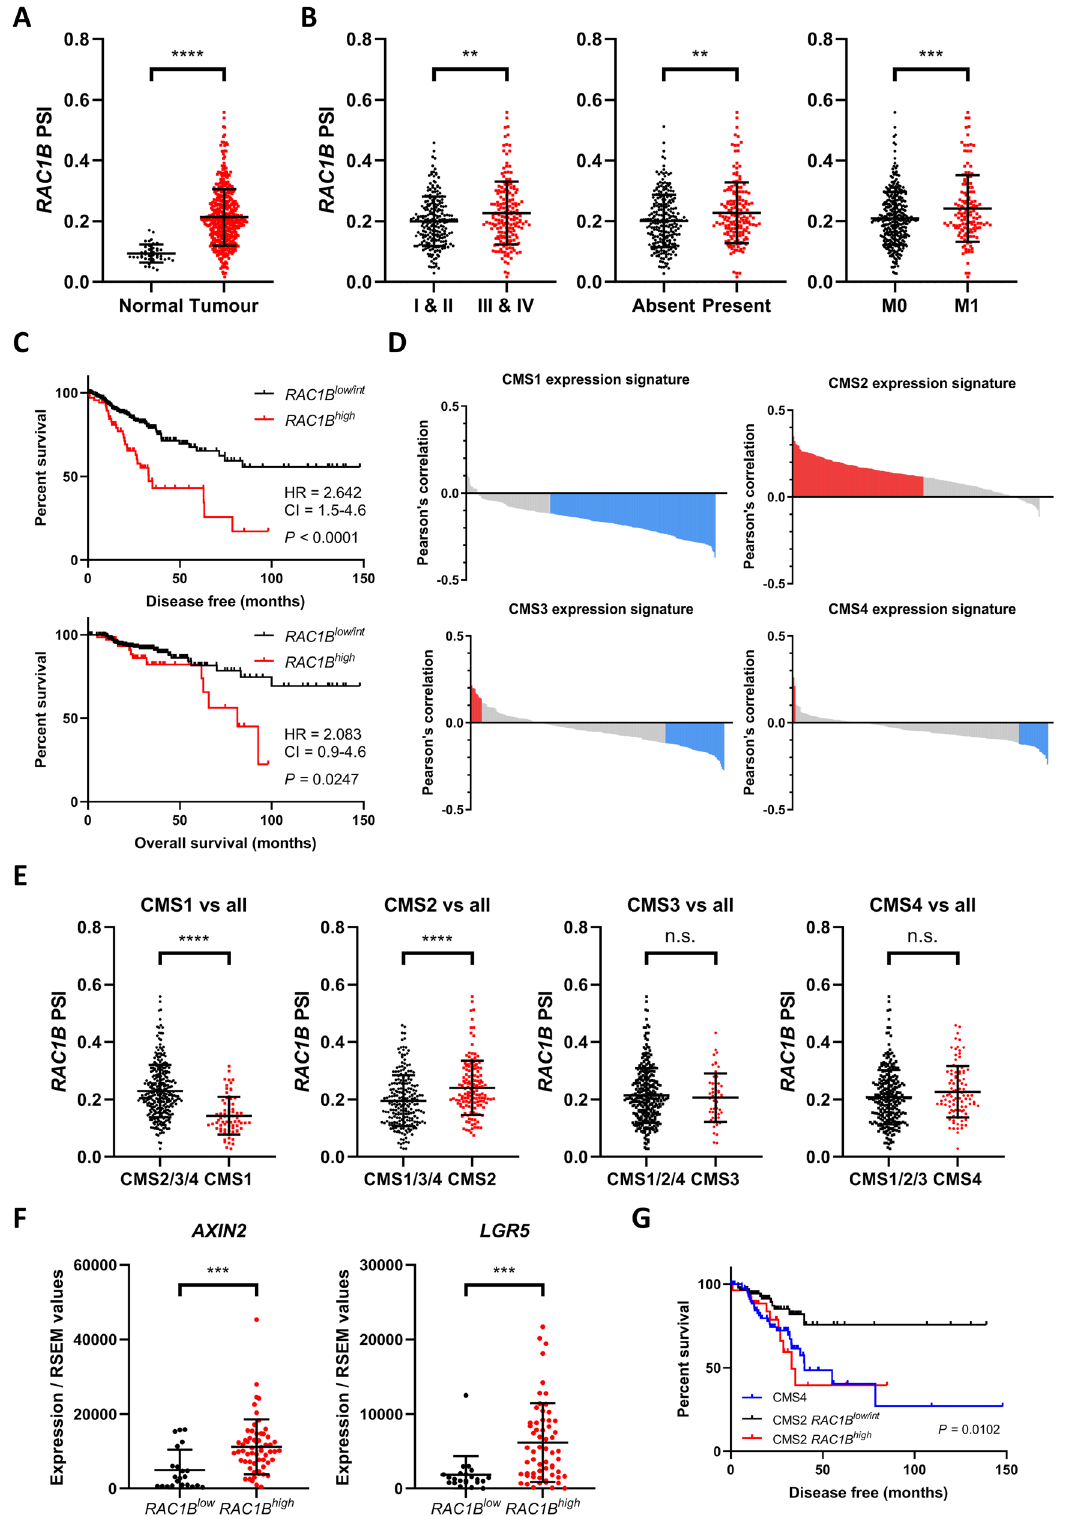
expression of RAC1B in MSI tumours and/or tumours carrying mutations in BRAF as hypothesised by the negative correlation with CMS1 (Fig. S1K). These data indicate RAC1B expression correlates with high levels of WNT signalling in human CRC. Apparently contradictory to these fi ndings, the prognosis of patients with WNT-activated CMS2 tumours is relatively